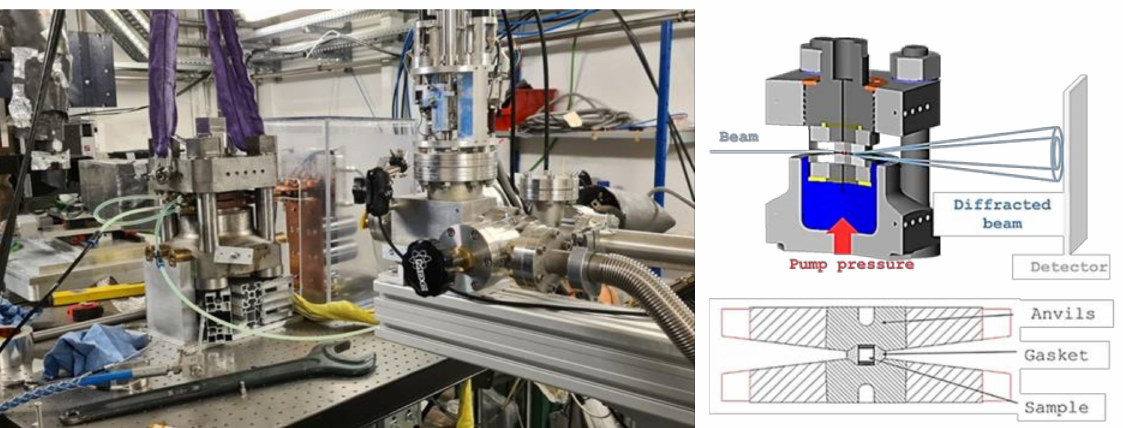
Figure 17. The compact very high-pressure SPS installed on PSICH É beamline at SOLEIL, French synchrotron. Scheme of the press set-up for collecting diffraction patterns—Details of the sample